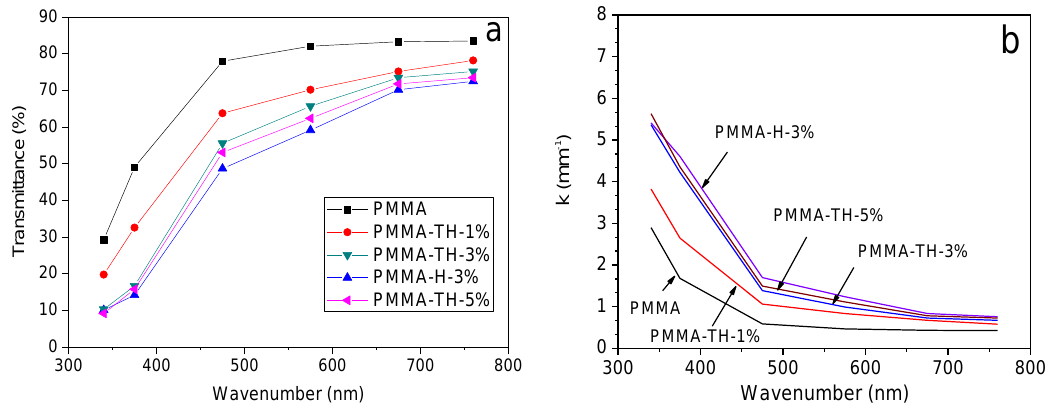
Figure 10. ( a ) Light transmittance and ( b ) attenuation coefficient of PMMA/reactive halloysite nanocomposite films.